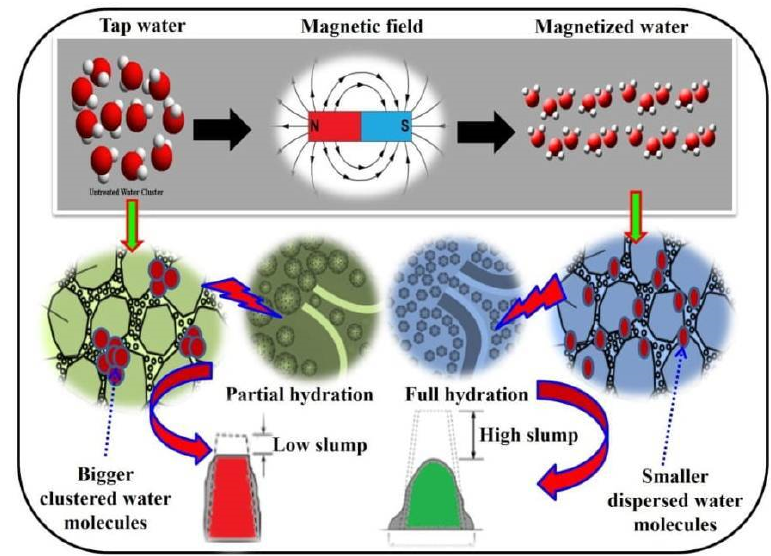
Figure 15. Mechanism of MFTW action on cement particles.